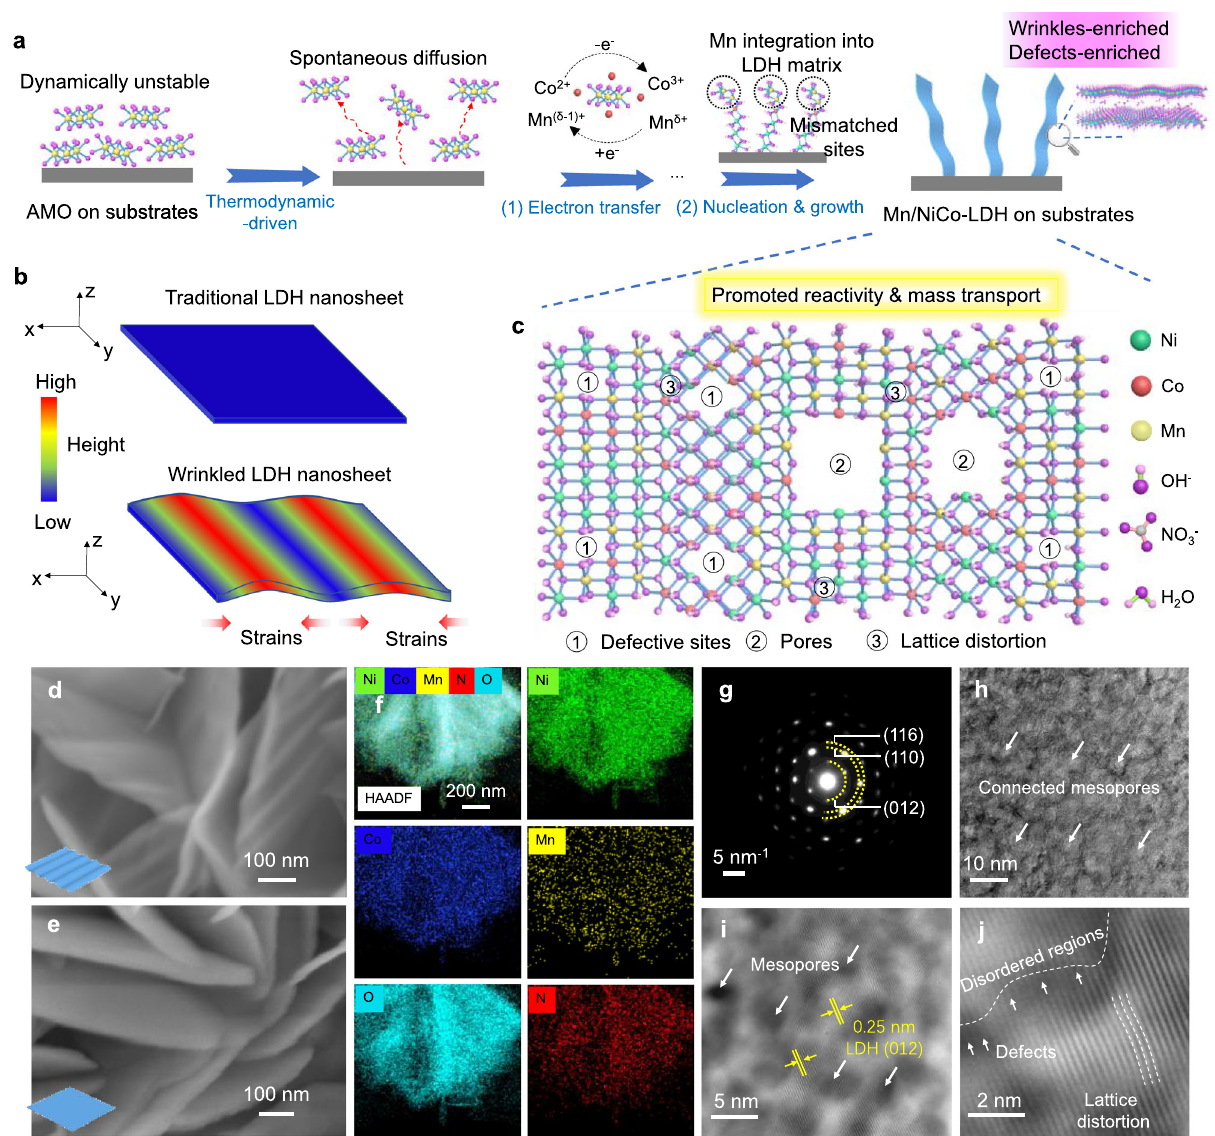
Fig. 1 Con fi guration and microstructure characterization of wrinkled Mn/NiCo-LDH. a Formation mechanisms of Mn/NiCo-LDH nanosheets with enriched wrinkles and defects. b The comparison of the traditional and wrinkled LDH nanosheets. c Schematic illustration for the molecular structure of wrinkled Mn/NiCo-LDH. d , e SEM images of d Mn/NiCo-LDH nanosheets and e traditional NiCo-LDH nanosheets. f AC-TEM elemental mapping for Mn/ NiCo-LDH nanosheets, g the corresponding SAED pattern. h AC-TEM image of Mn/NiCo-LDH nanosheets. i , j The as- fi ltered HAADF-STEM images of Mn/NiCo-LDH nanosheets by combining the origin and inverse-FFT